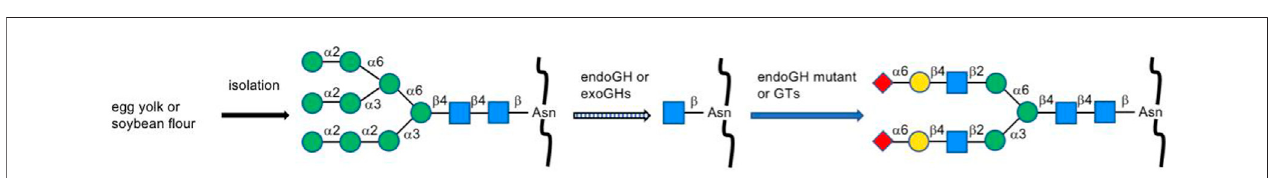
FIGURE 3 | Isolation of N -glycans from natural resources.